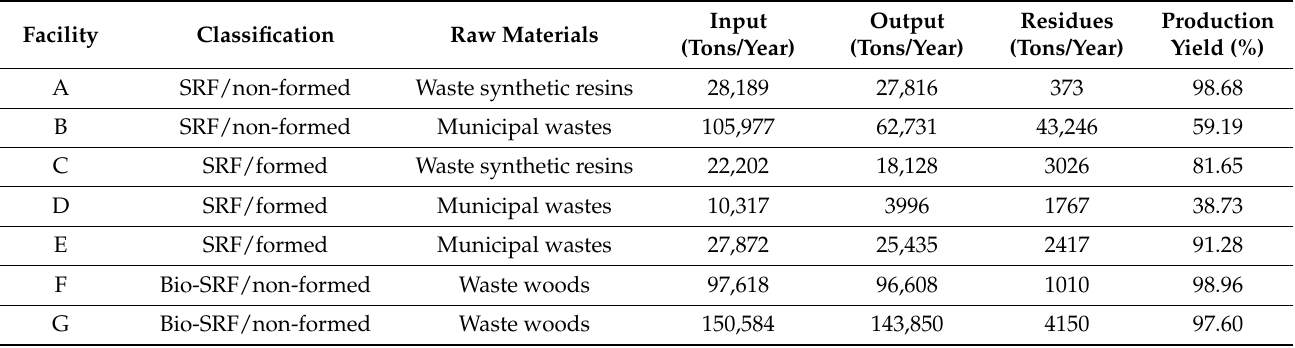
Table 1. Selection of SRF facilities for the study (2020).